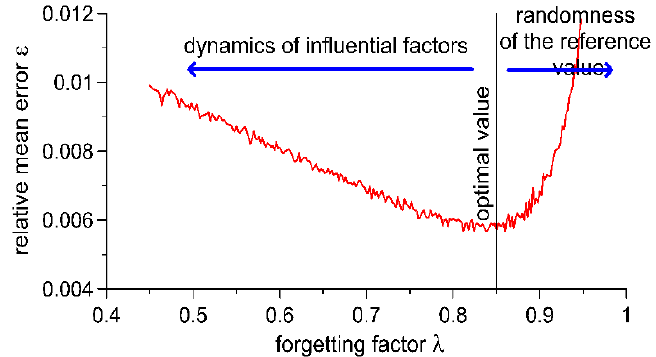
Figure 4. Sample characteristic illustrating the impact of the forgetting factor on weighing error.